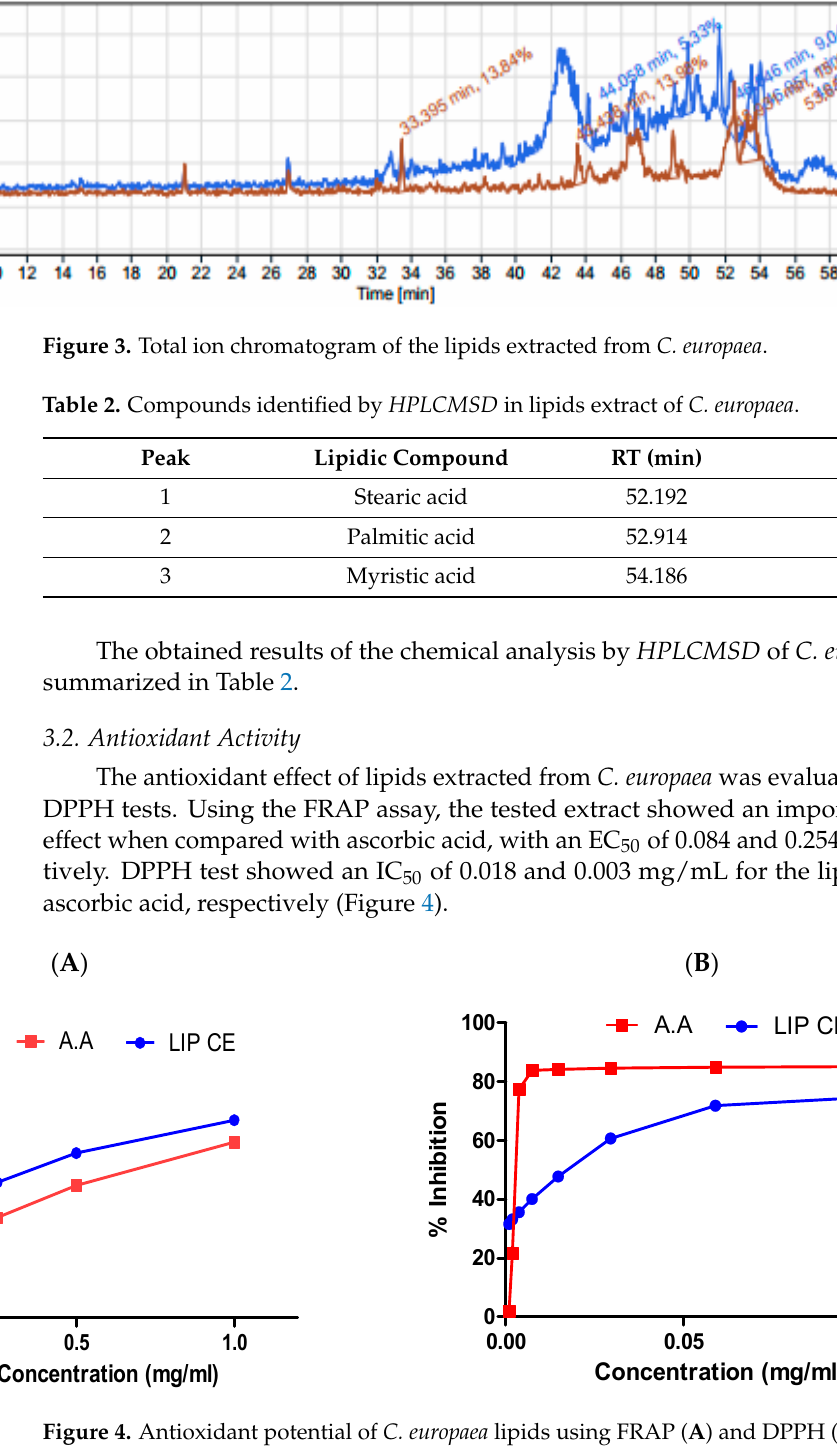
Figure 4. Antioxidant potential of C. europaea lipids using FRAP ( A ) and DPPH ( B )